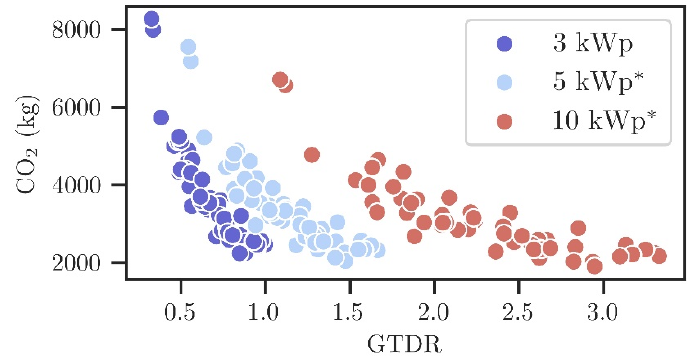
Figure 12. Annual household CO 2 emissions as a function of GTDR (n = 55). (* upscaled from 3 kWp PV generation profiles).